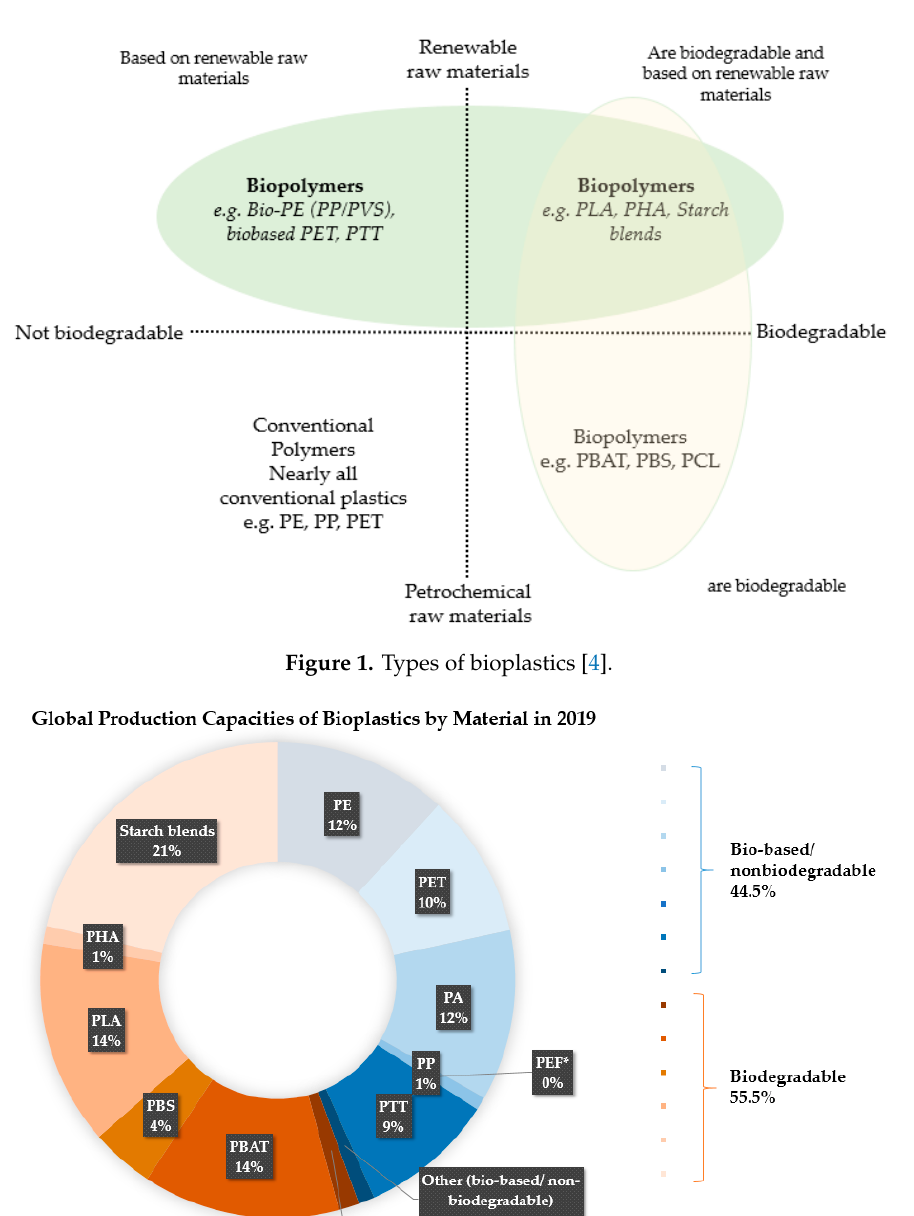
Figure 2. Global production capacities of bioplastics by material in 2019 [6]. PE, polyethylene; PP, polypropylene; PET, poly (ethylene terephthalate); PVC, polyvinyl chloride; PTT, poly (trimethylene terephthalate); PBAT, poly (butylene adipate-co-terephthalate); PBS, polybutylene succinate; PCL, poly( Ԑ -caprolactone) [8], PLA, polylactide; PHA, poly (hydroxyalkonate).